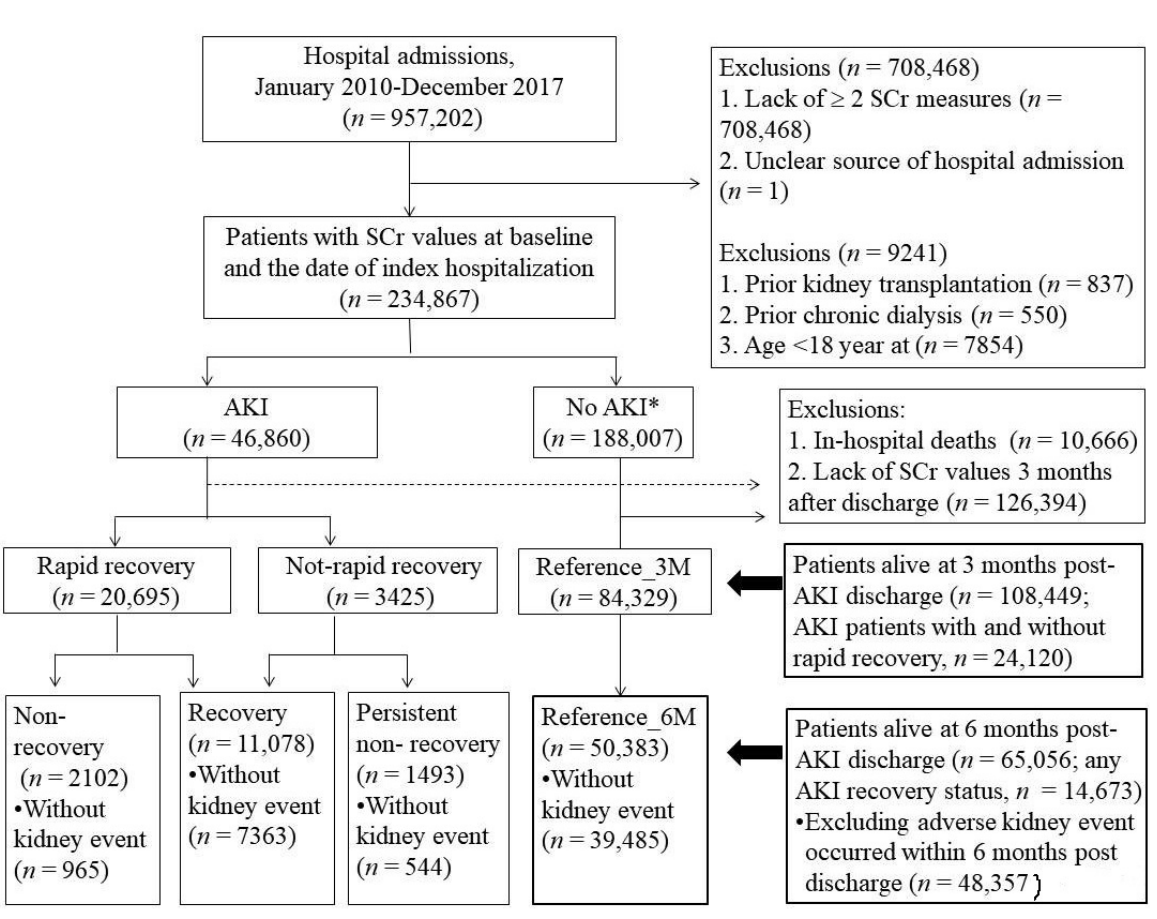
Figure 1. Flow chart of the patient selection AKI: acute kidney injury; not-rapid recovery, defined by the 3-month SCr ≥ 1.5 baseline SCr; * no AKI (neither at admission nor during hospitalization) = control group; non-recovery = post 6-month SCr ≥ 1.5 baseline SCr.